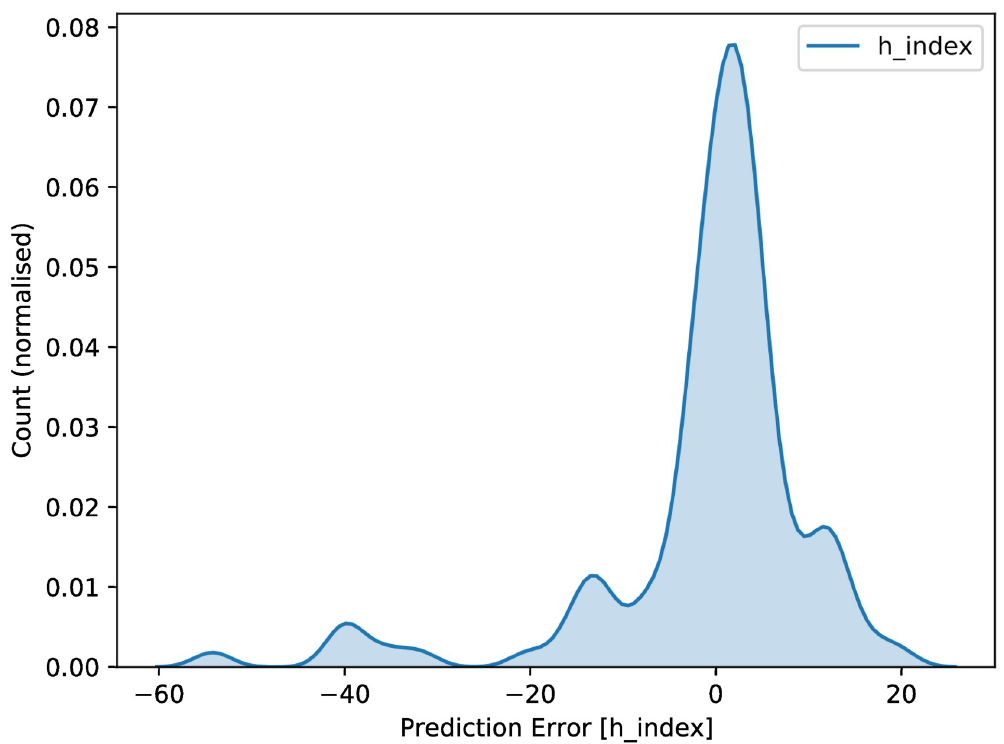
Fig 5. KDE plot of h-index prediction error. The prediction error is the difference between the true and predicted value. Thus, a negative number shows the network under-predicted, a positive value showed the network over-predicted.